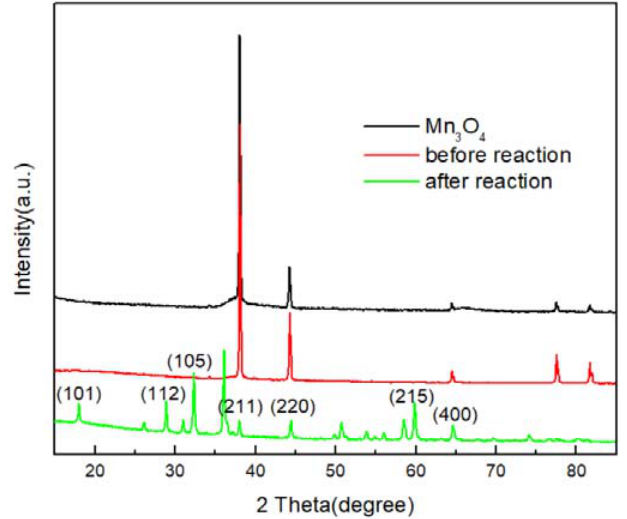
Figure 8. XRD patterns of Mn 3 O 4 before and after reaction with phenol.